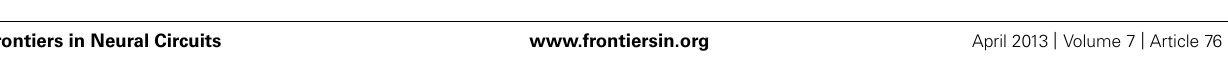
Frontiers in Neural